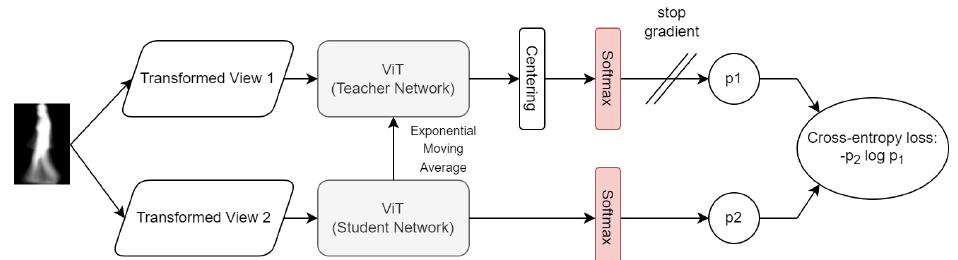
Figure 2. DINO self-supervised learning [20]. The goal of the student network is to match the probability distribution of a teacher network using cross-entropy loss, given different views of the same input